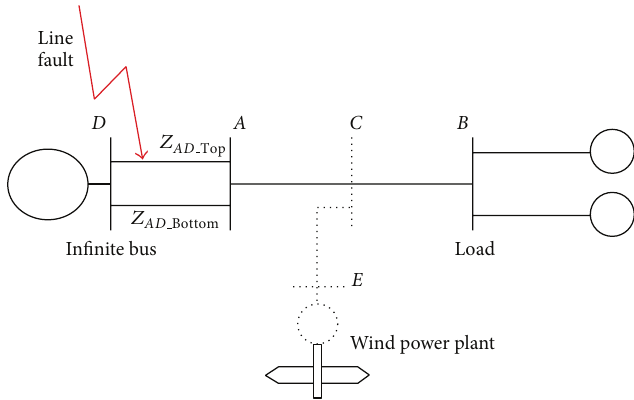
Figure 2: A test system suffering a short circuit fault.